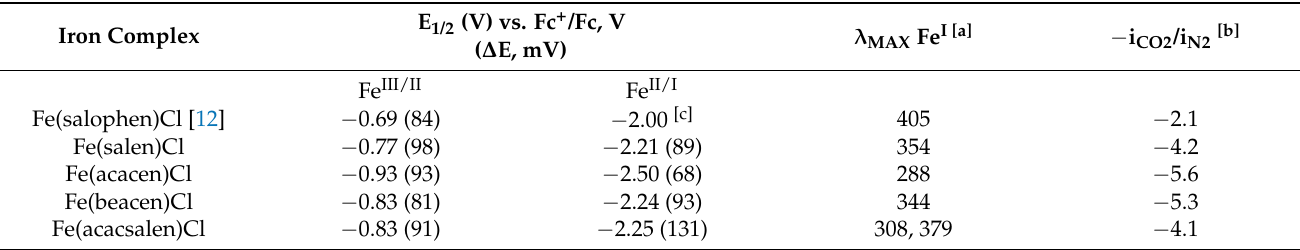
Table 1. Electrochemical and spectroscopic characterization of iron complexes employed in this work.